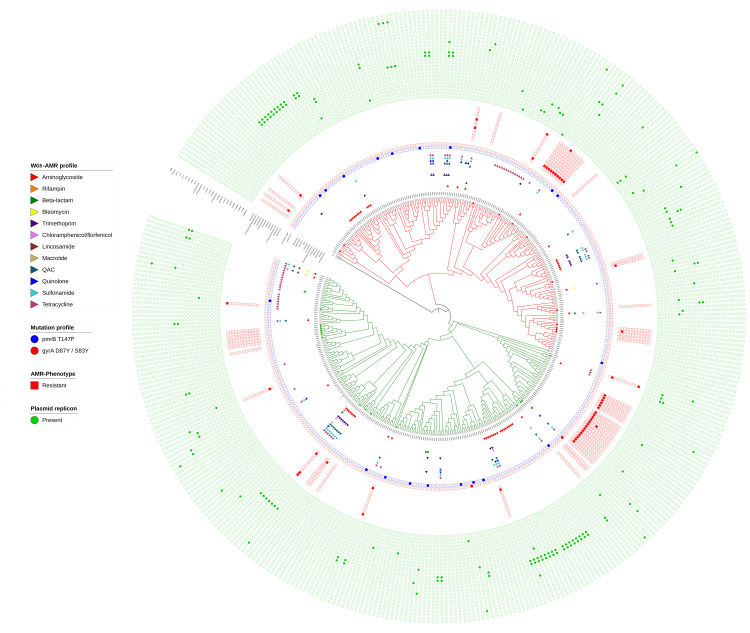
Genotypic and phenotypic prediction of antimicrobial resistance (AMR) in
Salmonella ser. Mbandaka.AMR genes were predicted from the genomic assemblies and categorized into different groups based on the antibiotic class, as shown in the legend. A cladogram of the MCC tree rooted to outgroup (KY1 and ALT1) is shown at the center. Tree branches are colored to visualize the two major groups. The first circular layer immediately around the tree shows the presence (colored triangle) or absence (no color) of genes resistant to the corresponding antibiotic class. The next two circular layers represent the types of point mutations (pmrB T147B – blue, gyrA D87Y/S83Y – red) identified in
Salmonella ser. Mbandaka genomes. Newly sequenced isolates (n = 66) formed a representative dataset in the context of their phylogenetic location. The phenotypic resistance profiles of these representative isolates against 12 different antibiotics are depicted in the next circular layer. This is followed by an outermost circular layer that shows the presence (dark) and absence (light) matrix of 26 plasmid replicons in the analyzed genome assemblies. The isolates that showed a match to both phenotypic and genotypic prediction of AMR are marked with a dark color for the tree leaf node. Figure was generated using iTOL v.4.3.2
19.